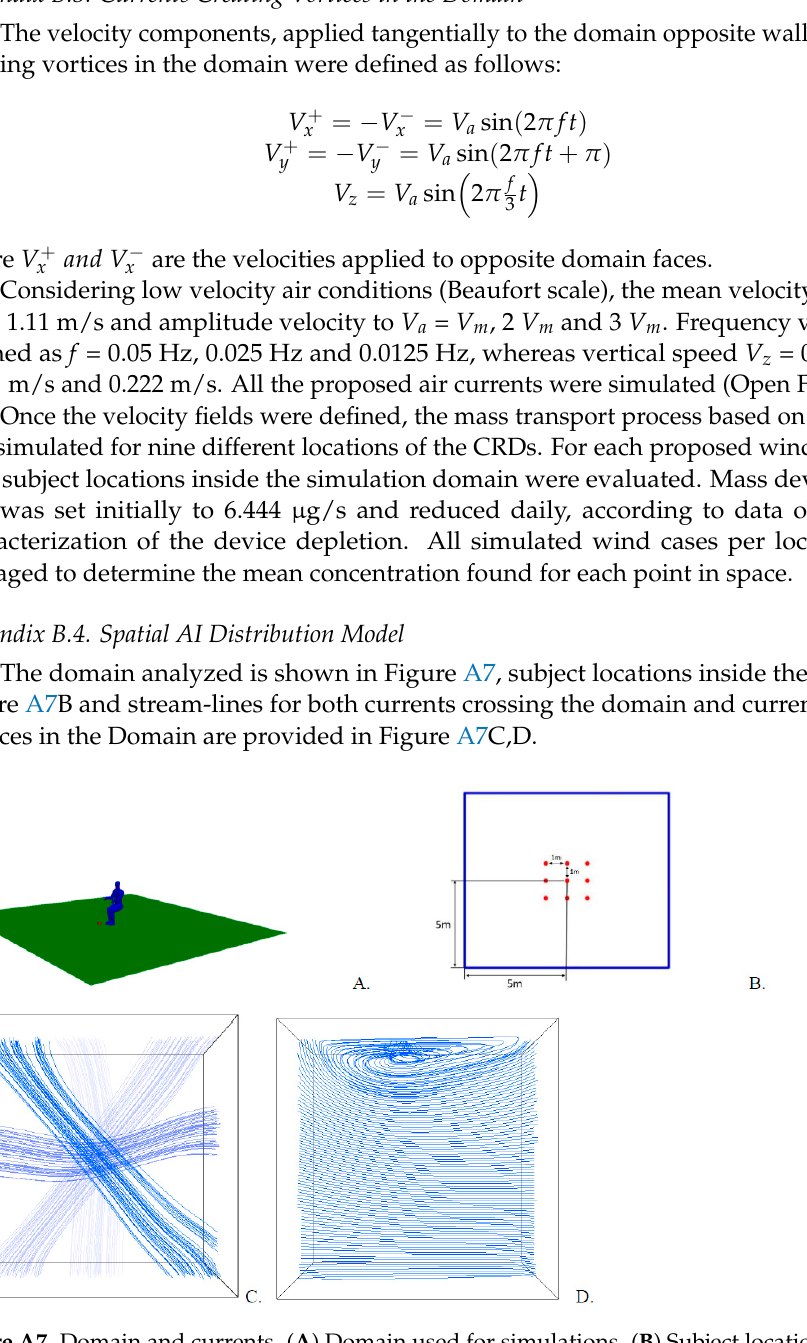
Figure A7. Domain and currents. ( A ) Domain used for simulations. ( B ) Subject location inside the study domain. ( C ) Currents crossing the domain. ( D ) Currents creating